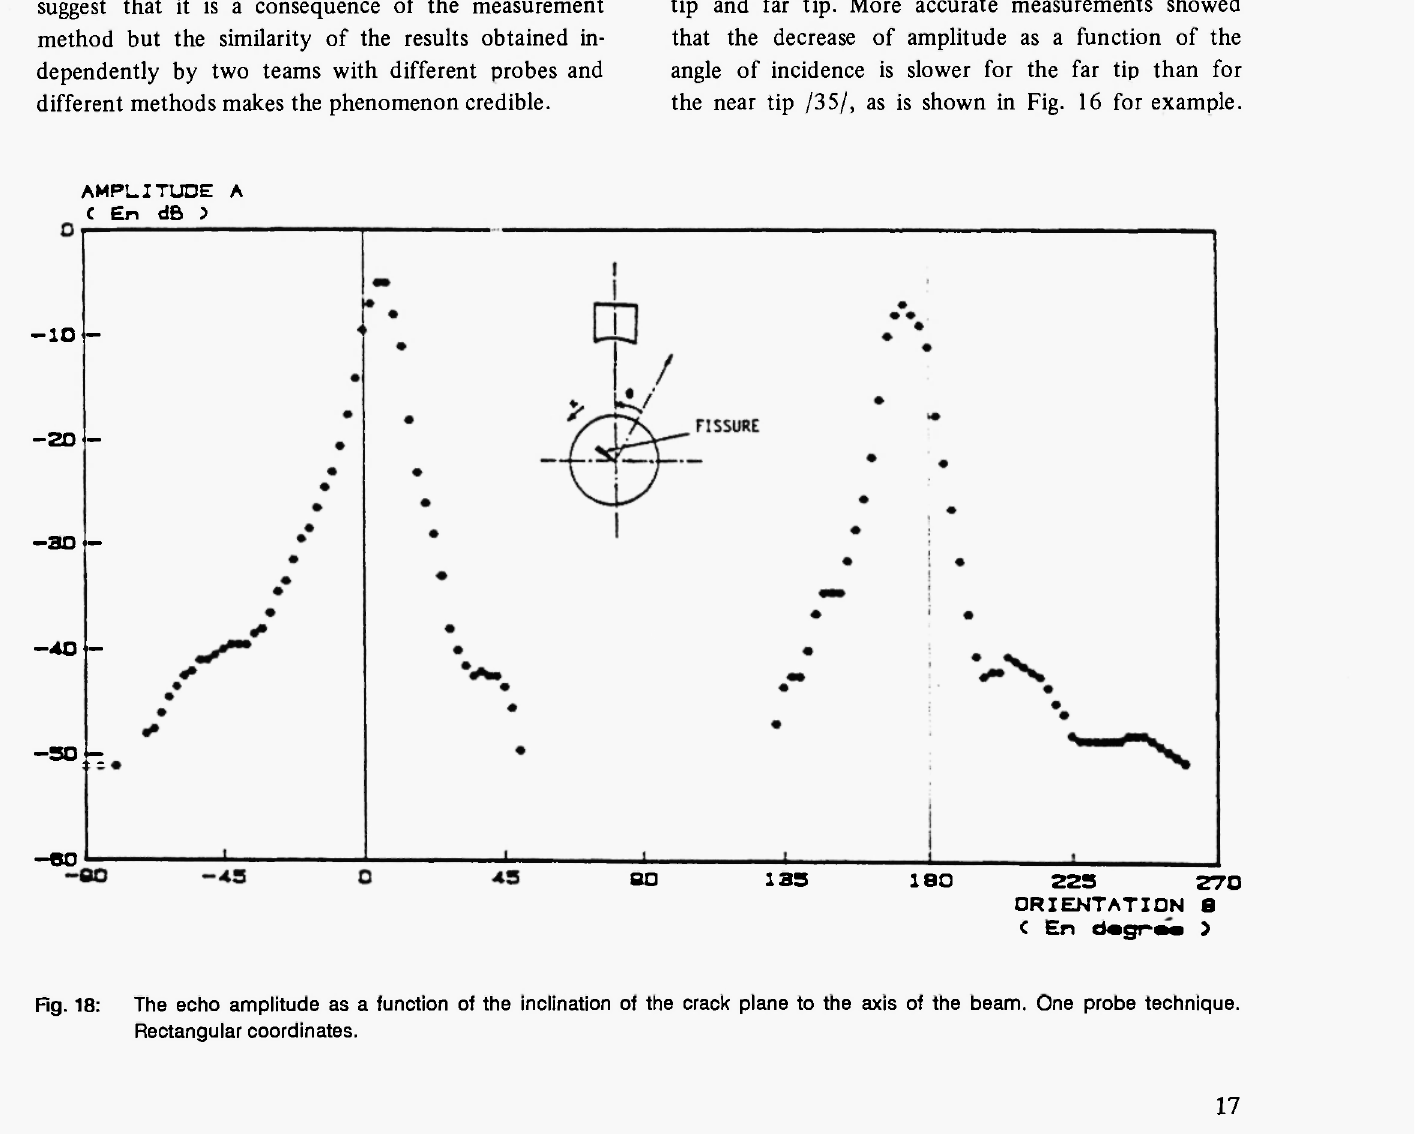
Fig. 18: The echo amplitude as a function of the inclination of the crack plane to the axis of the beam. One probe technique. Rectangular